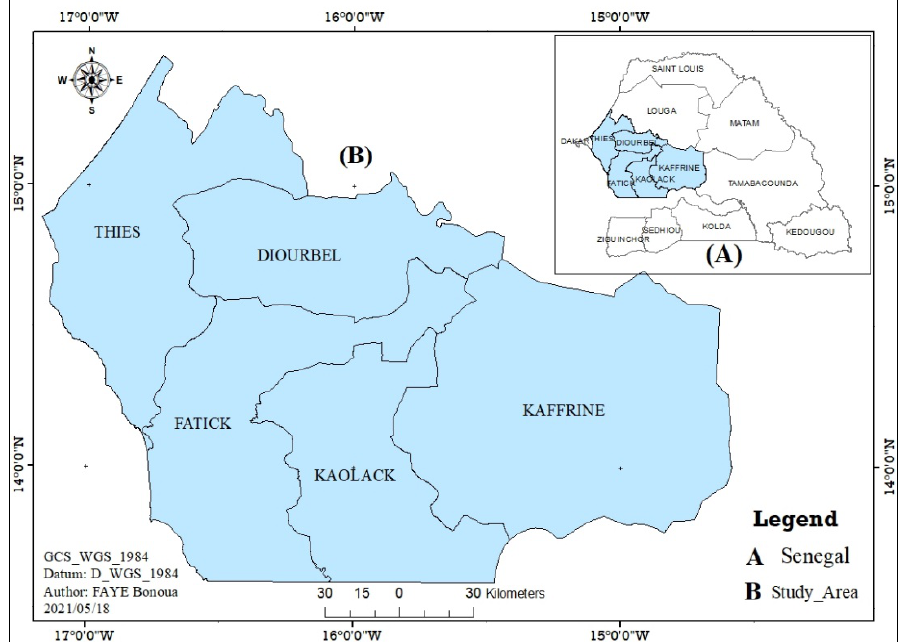
Figure 1. Geographic information: ( A ) represents the blue color represents the localization of the study area within Senegal; ( B ) represents the Groundnut Basin with five regions.